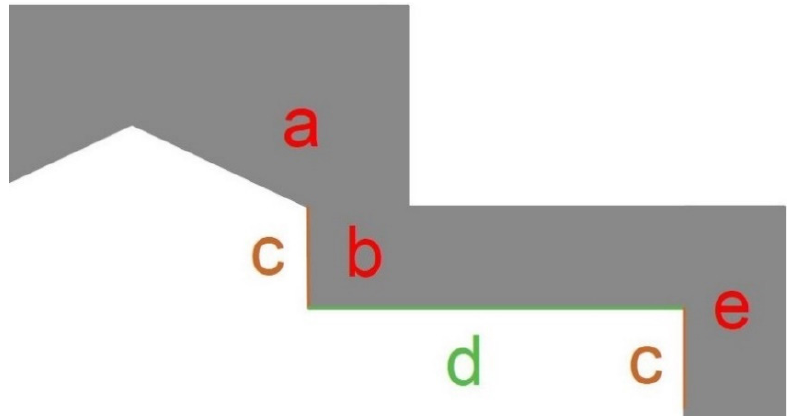
Figure 10. Detail of MDZ (Figure 1b) presenting the location where individual SPD processes occur. For locations ( a – e ), see items ( a – e ) in the text (beginning of Discussion)